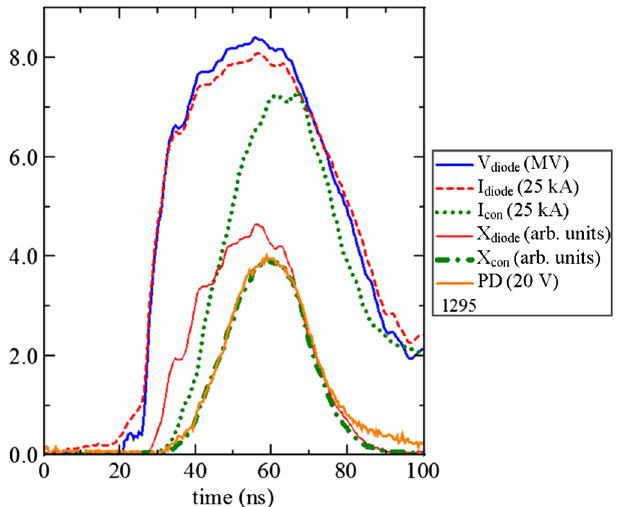
FIG. 5. Electrical traces for shot 1295 with a 40 cm gap. I the total current entering the diode region, I impacting the converter, X PD is the signal from the photodiode 5° off the axis of symmetry.